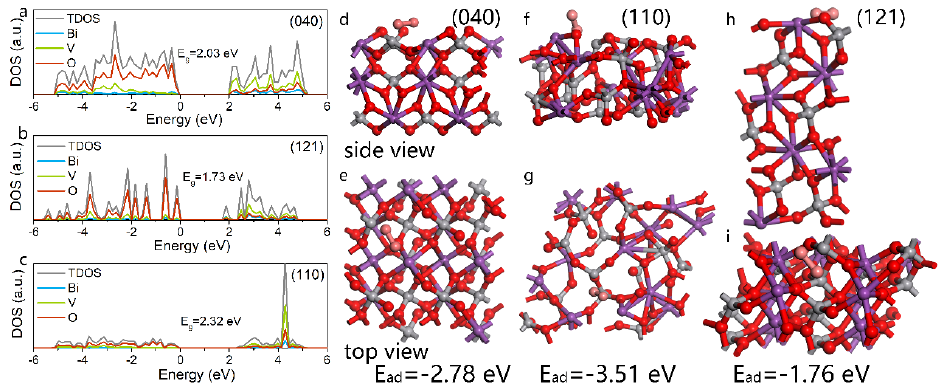
Figure 5. The density of states for the ( a ) (040), ( b ) (121), ( c ) (110) slab; the side view of a O 2 molecule adsorbed on ( d ) (040), ( f ) (110), ( h ) (121) slab, and the top view of a O 2 molecule adsorbed on ( e ) (040), ( g ) (110), and ( i ) (121) slab.